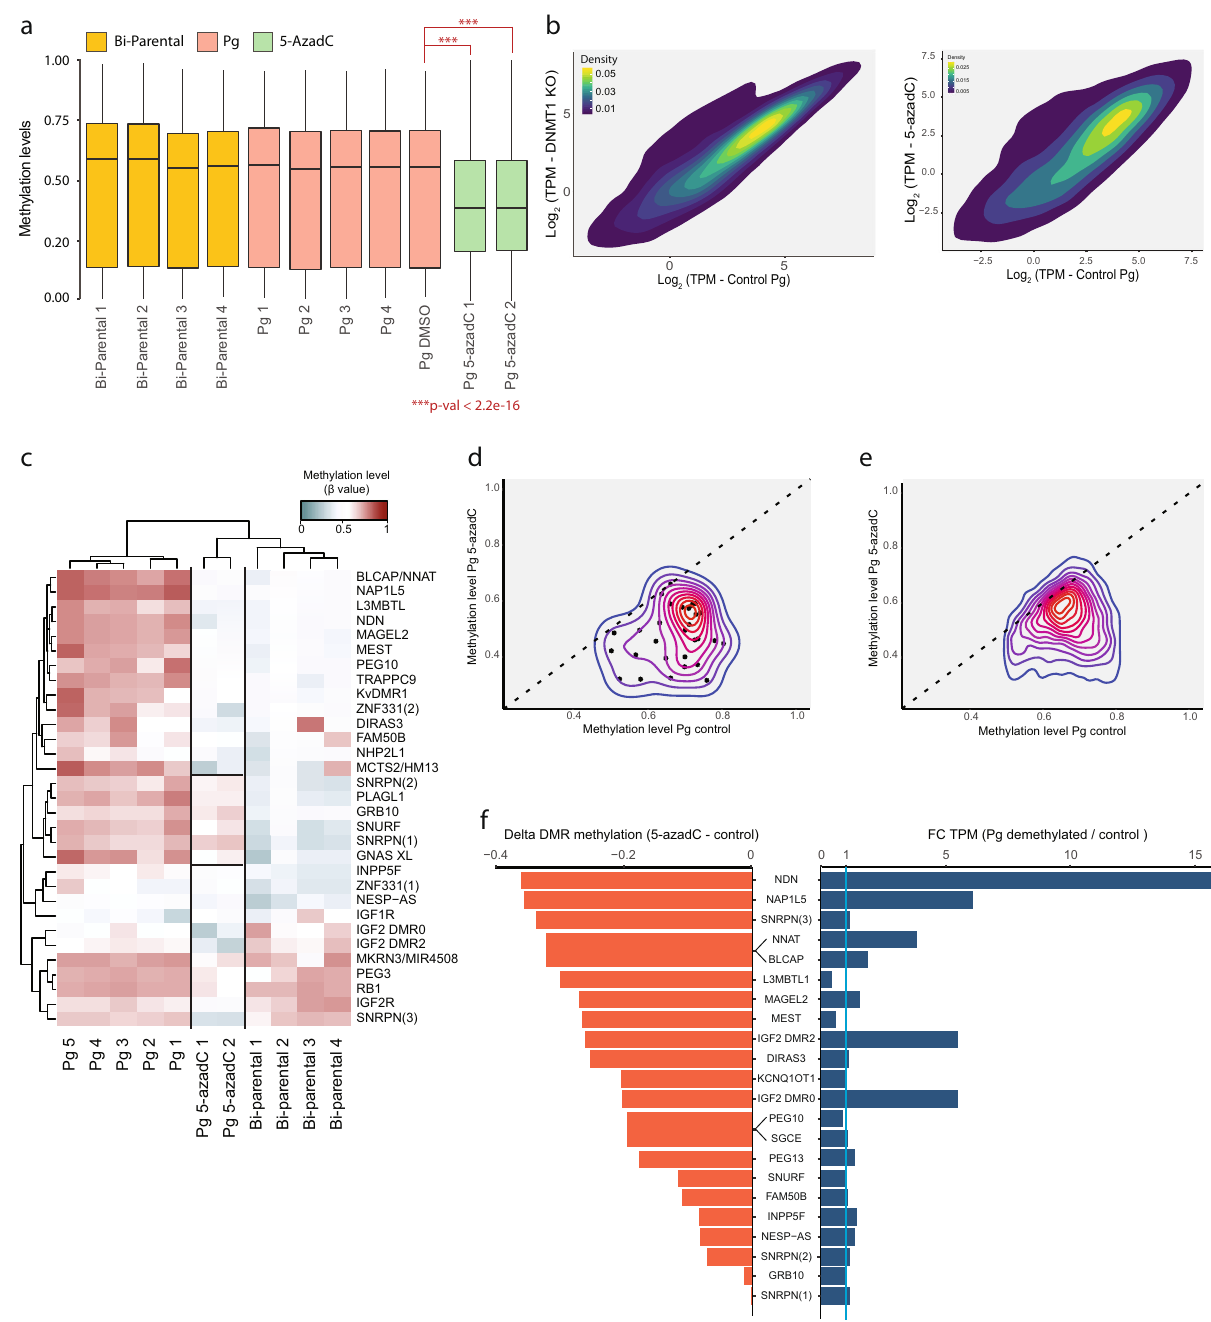
Fig. 1 Global DNA demethylation in parthenogenetic human ESCs. a Boxplots displaying the median with 25th – 75th percentile and range of global DNA methylation levels ( β values) across all analyzed CpGs in bi-parental hESCs (yellow), control parthenogenetic hESCs (red) and 5-azadC-treated parthenogenetic hESCs (green). *** P < 2.2e-16 (one-tailed, paired t -test). Whiskers represent values within 1.5 X the interquartile range. b 2D density plot showing the log 2 TPM of all genes in DNMT1-KO (left y axis) or 5-azadC-treated hpESCs (right y axis) vs. control hpESCs (empty Cas9 vector or DMSO, x axis). c Heatmap of mean methylation levels ( β values) of maternal DMRs in bi-parental, control parthenogenetic and 5-azadC-treated hpESCs. d 2D density plot showing mean methylation levels ( β values) of regions associated with maternal DMRs in control ( x axis) vs. 5-azadC-treated ( y axis) hpESCs. Only regions with mean methylation >0.5 in control hpESCs are included. Dashed line represents identical methylation (slope = 1). e Same analysis as in ( c ), performed for genome-wide regions associated with transcription start sites (TSS), 5 ′ -UTR and 1st exon. f Two-sided bar plot of PEGs that are expressed in bi-parental hESCs. Left bars (orange) illustrate the delta methylation levels ( β values) of the associated maternal DMR, between 5-azadC- treated and control hpESCs. Wide bars are used for DMRs that control several PEGs. Right bars (blue) represent fold change (FC) of the mean TPM between DNMT1 KO and 5-azadC-treated (referred to as demethylated) vs. control hpESCs. Blue line illustrates unchanged expression (FC =